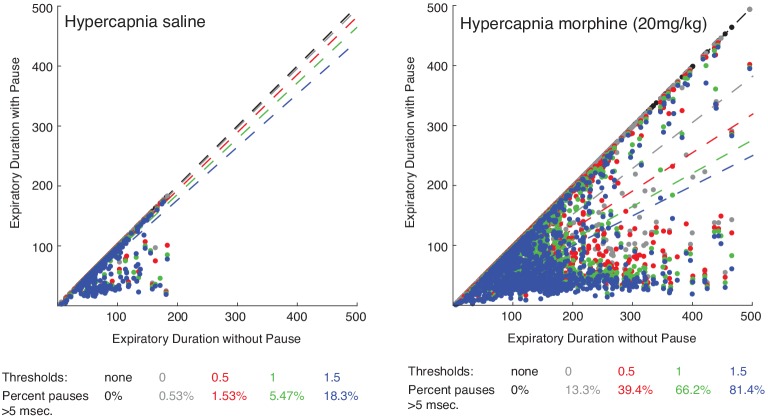
Scatter plot of expiratory duration with and without the pause to identify an effective airflow threshold.Scatterplots of 100 individual breaths (dots) from n = 15 animals and the line of best fit (dashed line) where the expiratory length (msec.) of breaths is calculated with or without a pause. The different colors represent various airflow thresholds (mL/sec.) where the pause is initiated (black: no threshold, gray: 0 mL/sec., red: 0.5 mL/sec., green: 1 mL/sec., blue: 1.5 mL/sec.). Under hypercapnia conditions after intraperitoneal saline injection (left), at a pause threshold of 0.5 mL/sec. less than 2% of all breaths had a pause defined greater than 5msec. However, after 20 mg/kg morphine in hypercapnia, 40% of breaths had a pause greater than 5msec. At a threshold of 0.5 mL/sec., since most breaths (>98%) under baseline conditions do not have any pause, this threshold was conservatively chosen for our analysis.